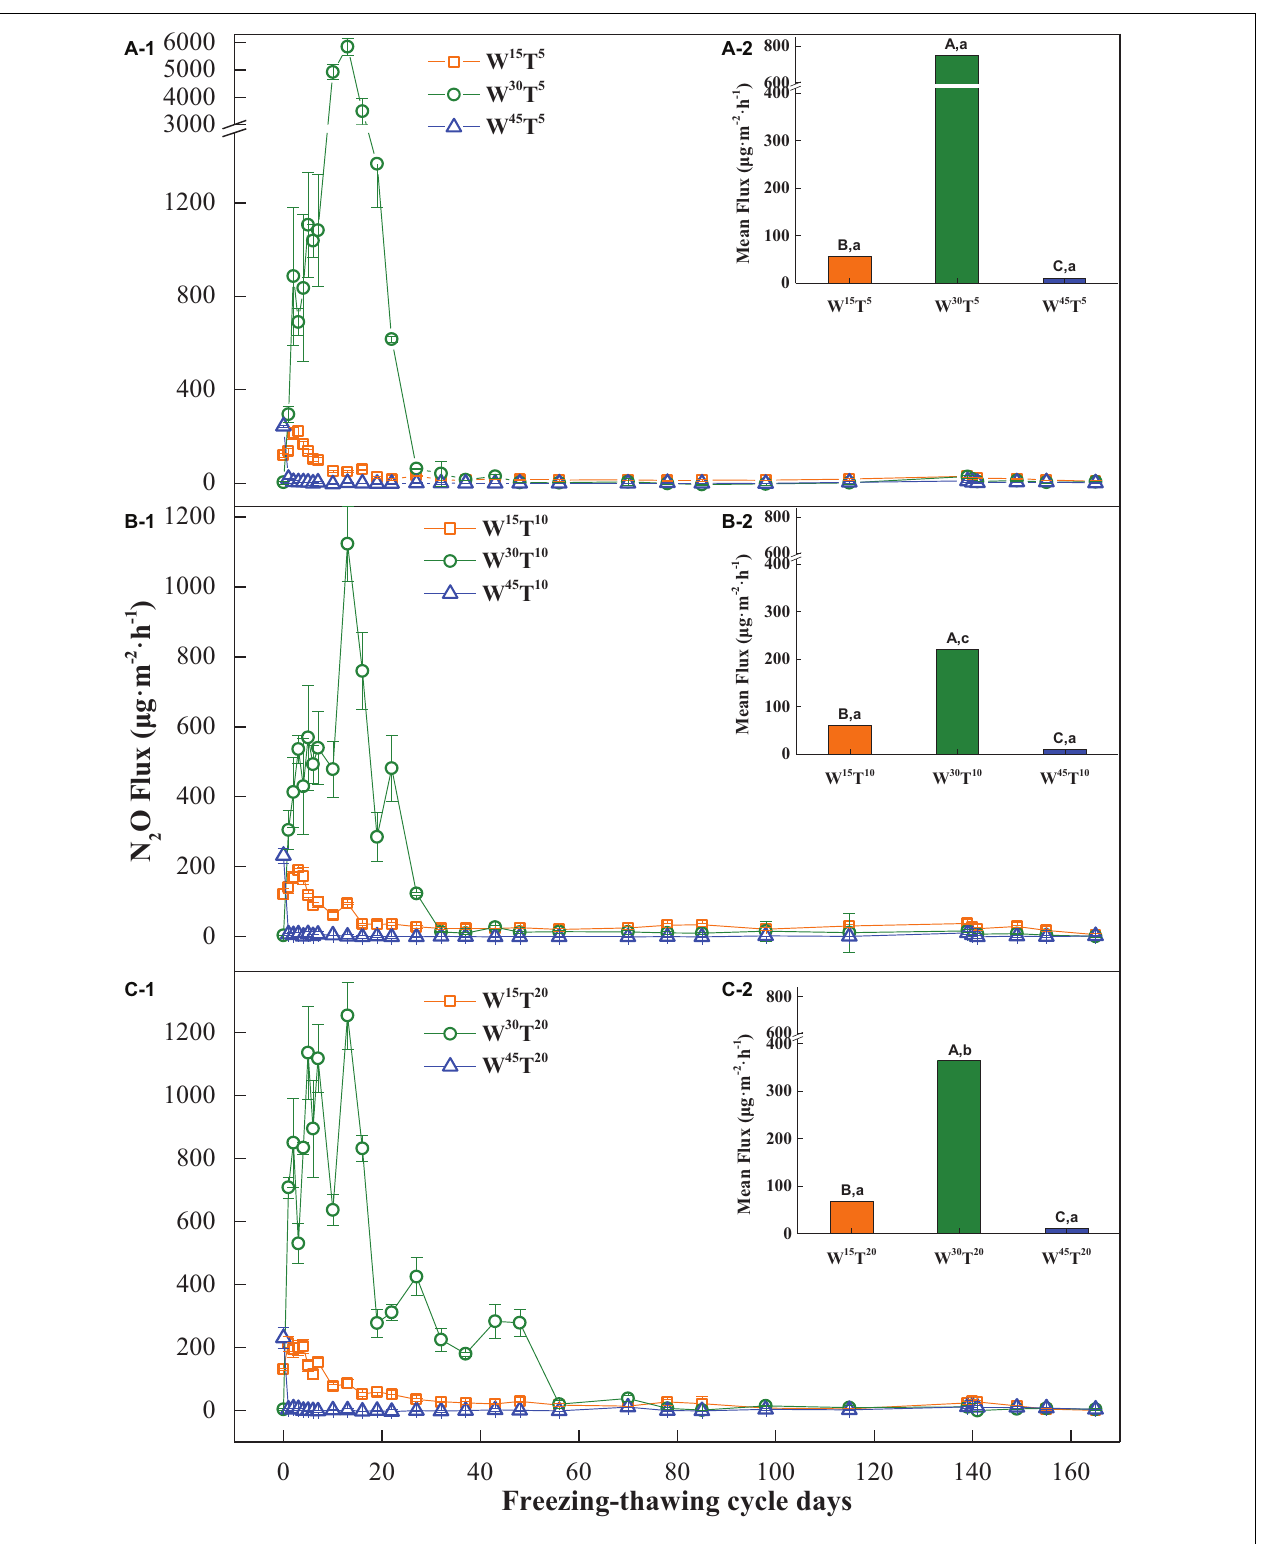
FIGURE 1 | (A-1 , B-1 , C-1) Dynamics and (A-2 , B-2 , C-2) average flux of N 2 O during freeze–thaw cycles. Capital letters above each bar indicate significant differences between different soil moistures with the same thawing temperature, and the lowercase letters indicate significant differences between different thawing temperatures with the same soil